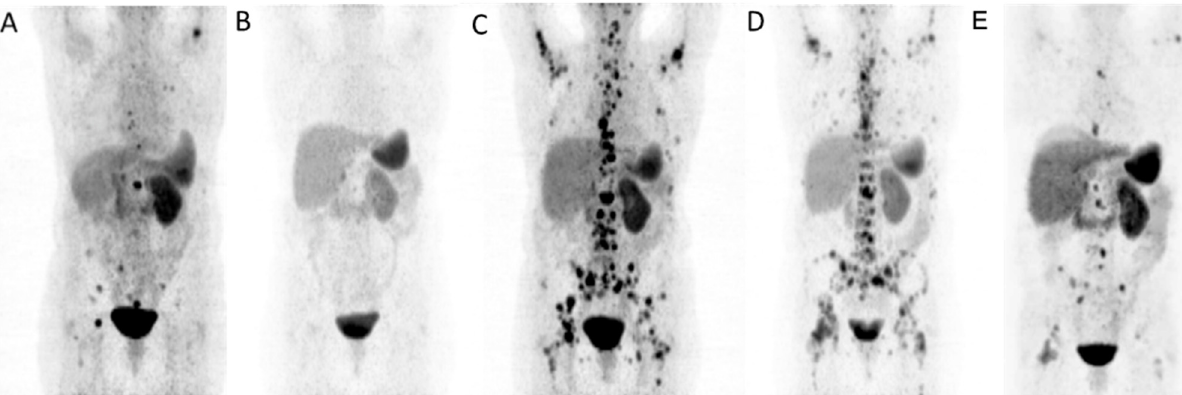
Figure 1. Maximum-intensity-projection 68 Ga-DOTATOC PET images of a patient with renal NET before ( A ) and after ( B ) four cycles of 177 Lu-DOTATATE (29 GBq) showing initial response. Repeat PRRT was performed 14 months later because of progressive disease ( C ) after successful PBSC harvesting and almost achieved disease stabilization ( D ) after 2 cycles (15.4 GBq) of re-PRRT and partial response ( E ) after additional 3 cycles (18 GBq).